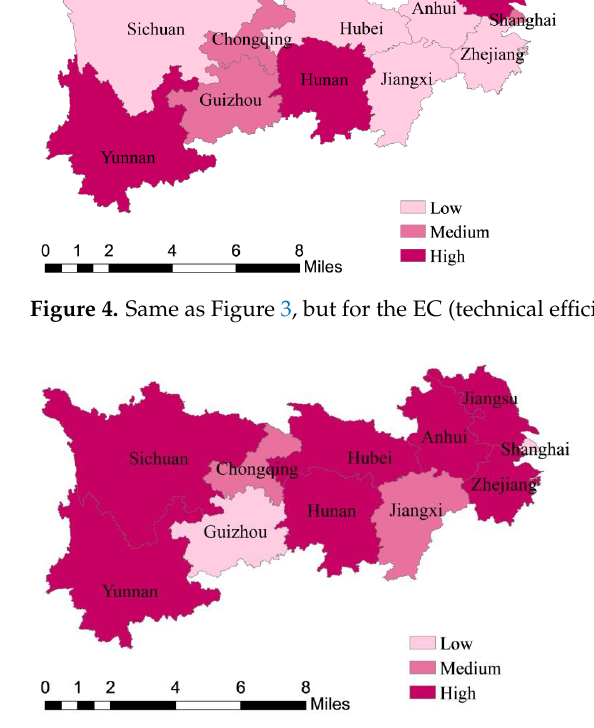
Figure 5. Same as Figure 3, but for the TC (technological progress) index.